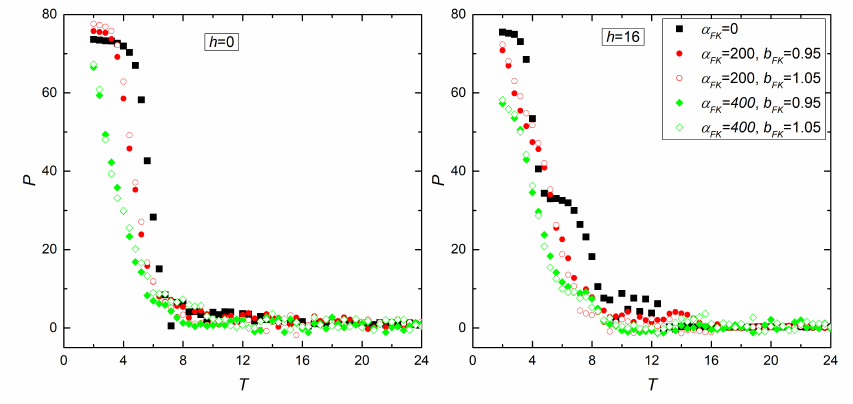
Figure 2. Temperature dependencies (unit: J FM potentials of the